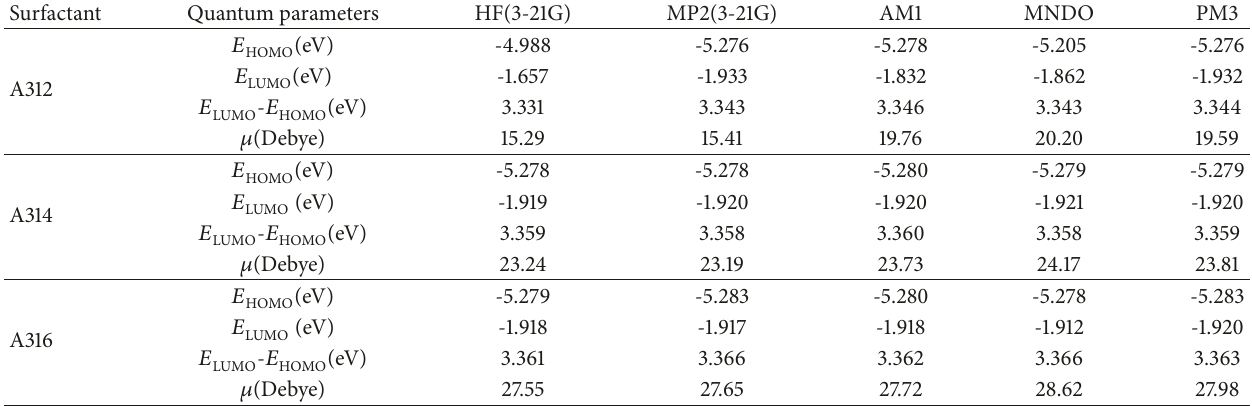
Table 6: Quantum chemical parameters of synthesized corrosion inhibitors A312, A314 and A316. Surfactant